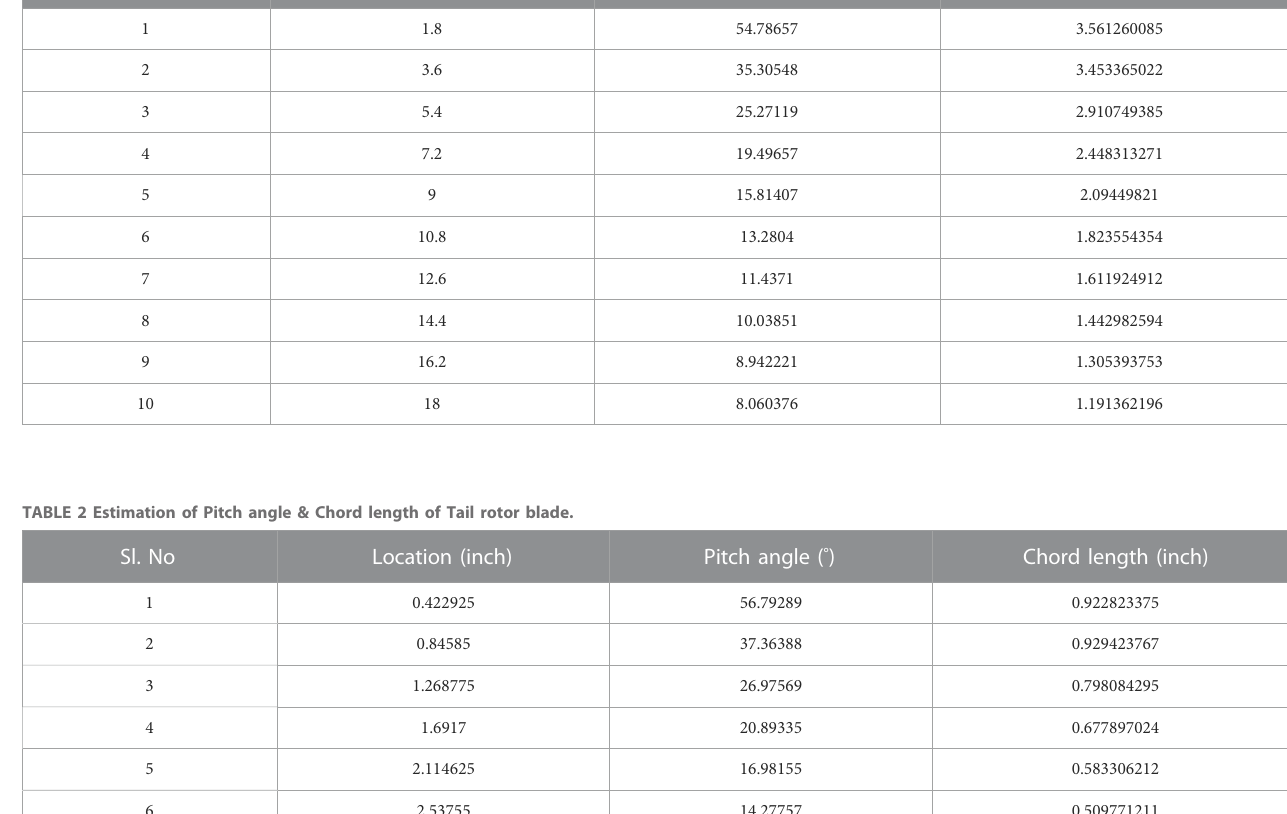
TABLE 1 Estimation of pitch angle chord length of main rotor blade. Sl. No